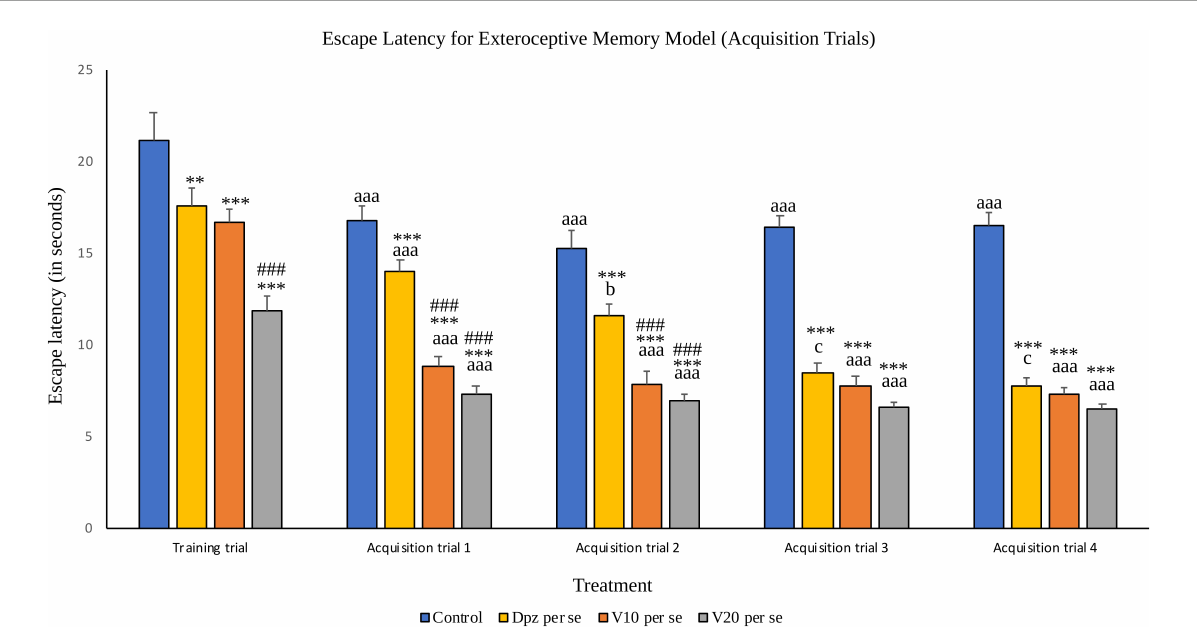
FIGURE5 Effect of vanillin and other treatments on escape latency (acquisition trials). Data are expressed as mean ± S.E.M. "***” denotes P < 0.001 with respect to the control group within the same day, and “**” denotes P < 0.01 with respect to the control group within the same day. “###” denotes P < 0.001 with respect to the standard treatment group within the same day. “aaa” denotes ( P < 0.001) with respect to the acquisition time of the same group during the training trial. “b” denotes P < 0.05 with respect to the retention time of the same group during acquisition trial 1, and “c” denotes P < 0.05 with respect to the retention time of the same group during acquisition trial 2.